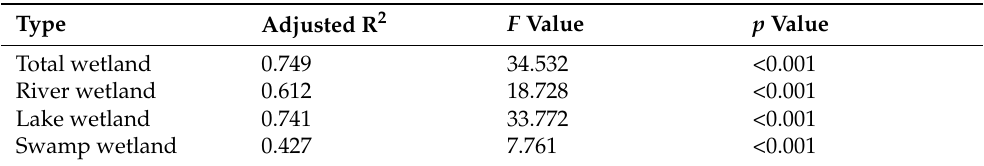
Table 3. Results of multiple linear regression analysis for changes in the area of different wetland types in Yunnan